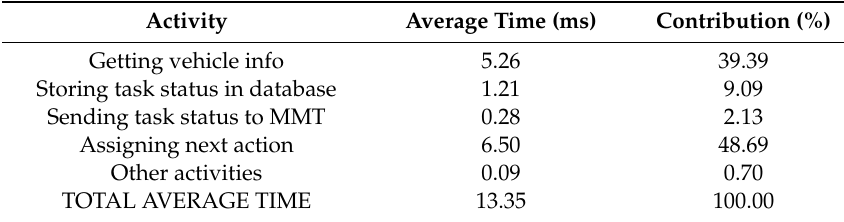
Table 6. Average times for processing the task status reports.